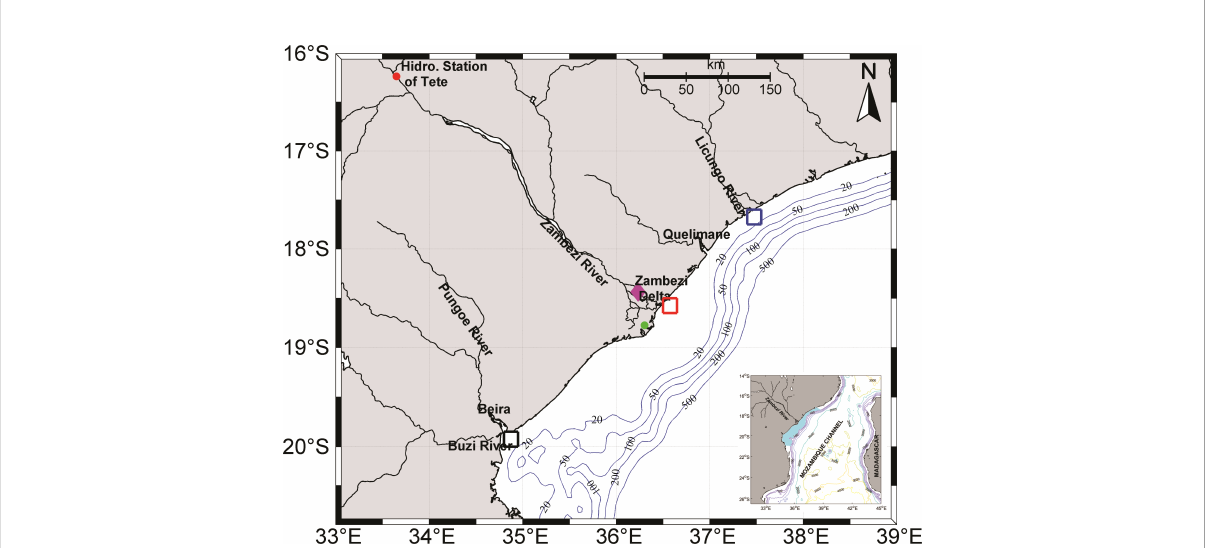
FIGURE 1 Map showing the study area. The black, red, and blue boxes are the small domains used to compare the suspended sediment concentrations in southern, central, and northern regions of the Sofala Bank. The green point represents the area of the wind speed time series. The magenta box represents the area of rainfall time